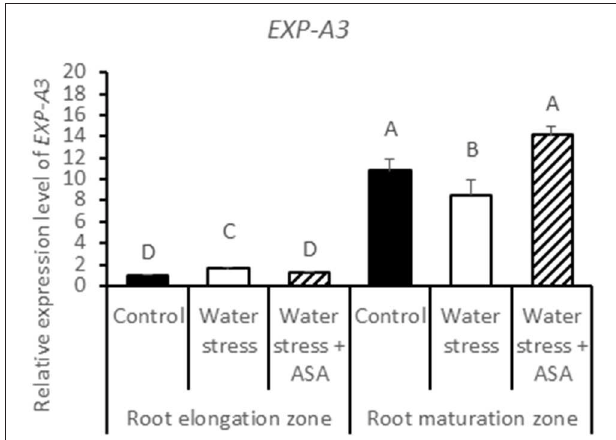
FIGURE 11 | Relative gene expression level of EXP-A3 in tall fescue roots exposed to non-stress control, water stress, and water stress with ASA treatment. The data represent mean ± SE ( n = 4 replicated pots of plants and each pot with multiple plants). Columns marked with the same letter are not significantly different at p < 0.05